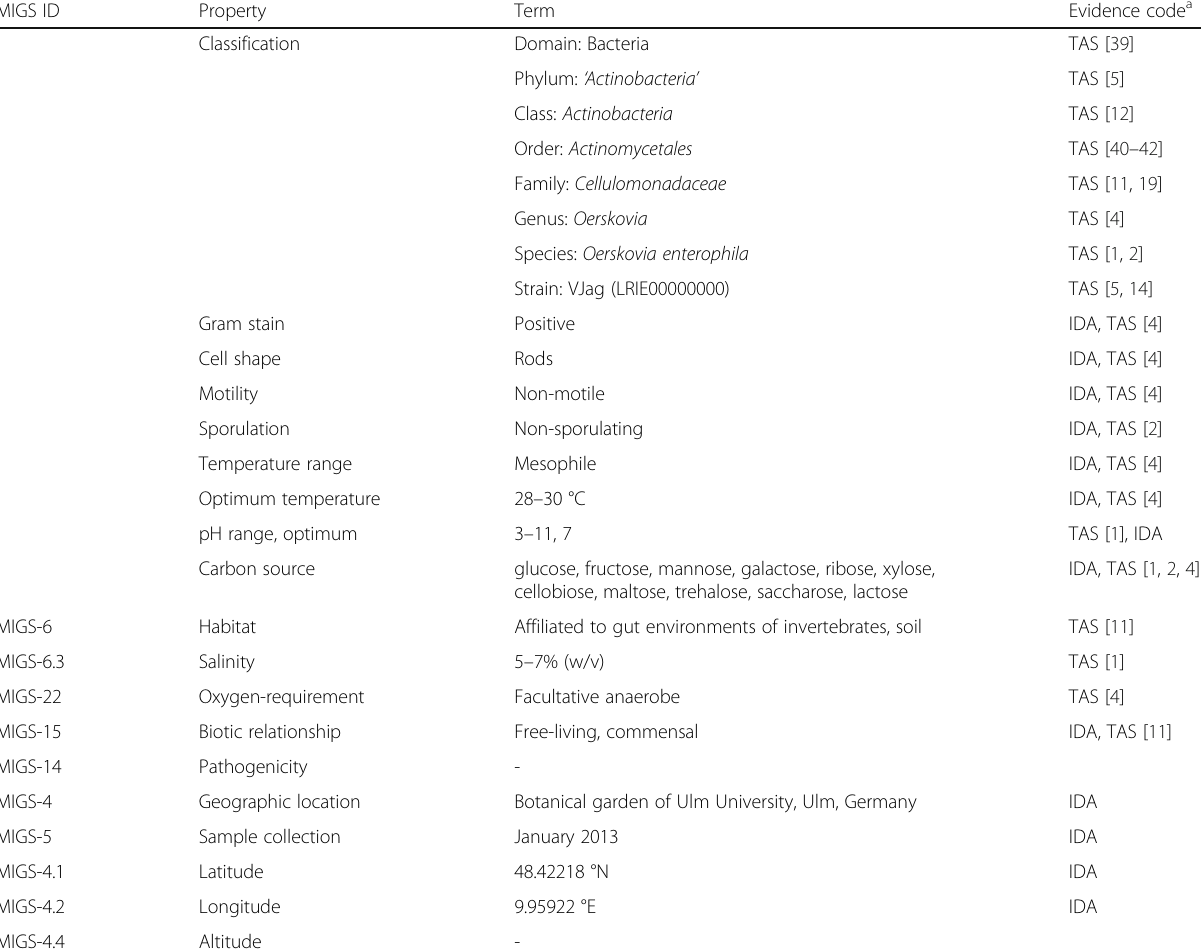
Table 1 Classification and general features of O. enterophila VJag according to the MIGS recommendations